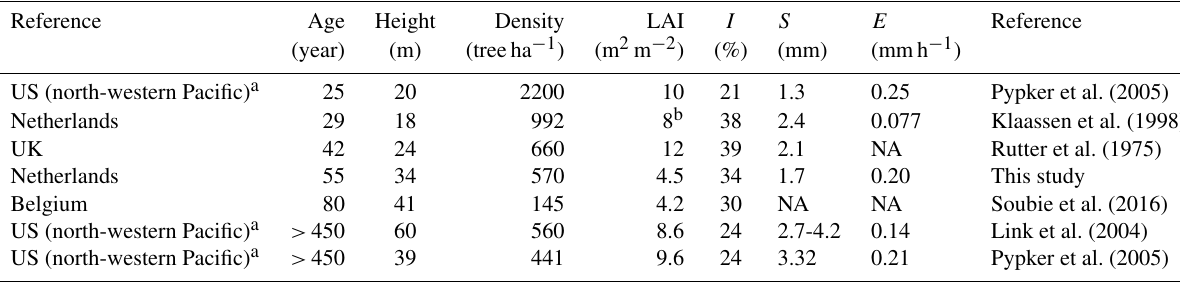
Table 8. Summary of canopy properties and interception parameters for Douglas fir forests.